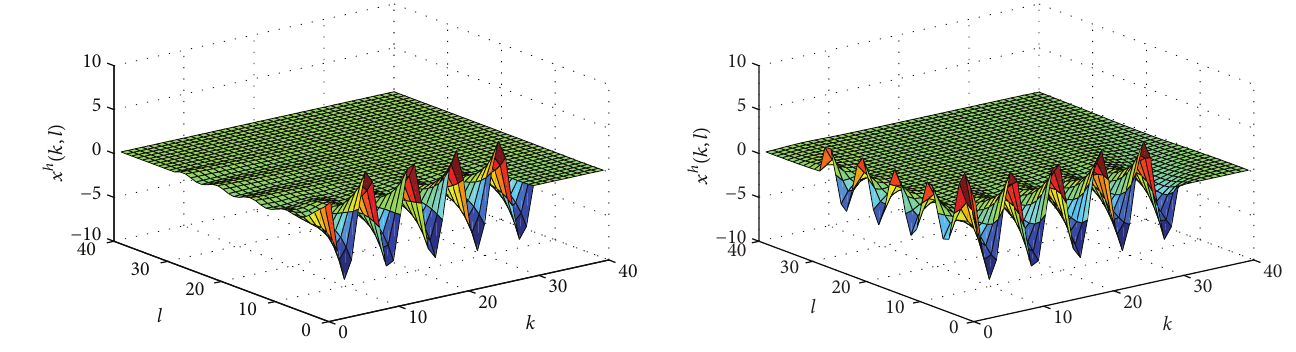
Figure 1: The state trajectory of 𝑥 ℎ (𝑘,𝑙) with 𝑎 2 = −0.6 .